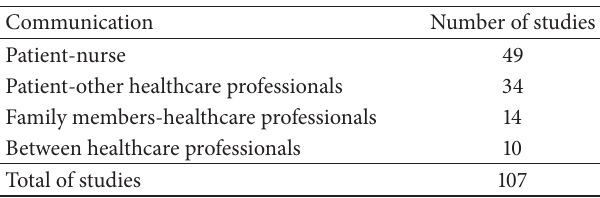
Table 5: Communication between